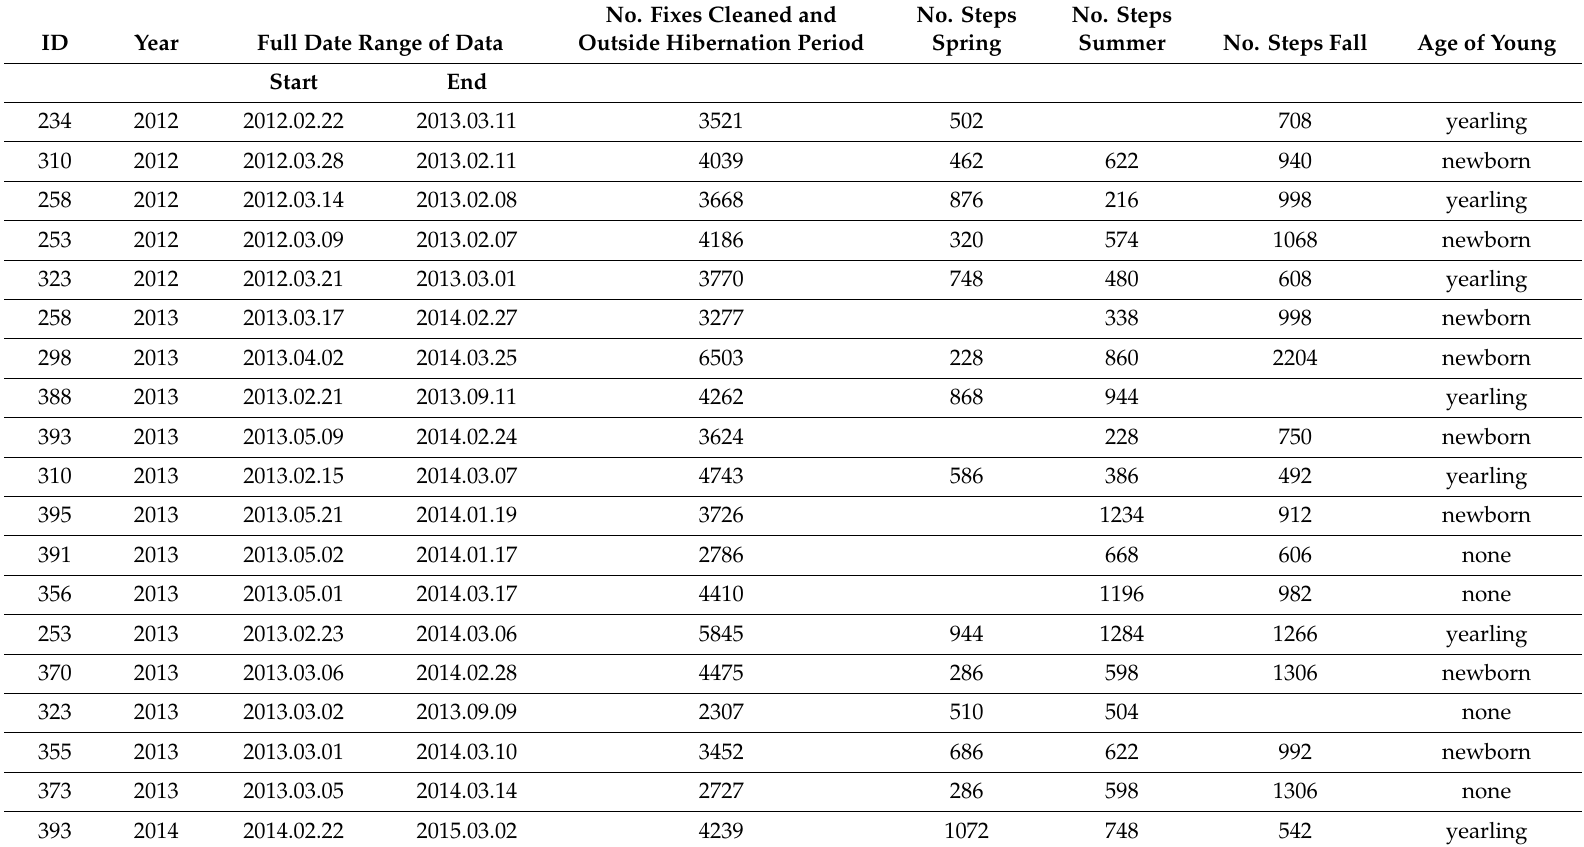
Table A1. Female bear ID, year, and date range of GPS collars used in the analyses. Number of fixes outside the hibernation period are the number of GPS locations acquired after cleaning data for inaccurate fixes. Number of steps used in the step selection function analysis for each season are also provided. Steps were only used in the analysis if the start and end points of a step were at consecutive 45-min intervals, indicating that there were no missing fixes between the two locations. Steps were only used for a season if a full season’s worth of data were available for that bear